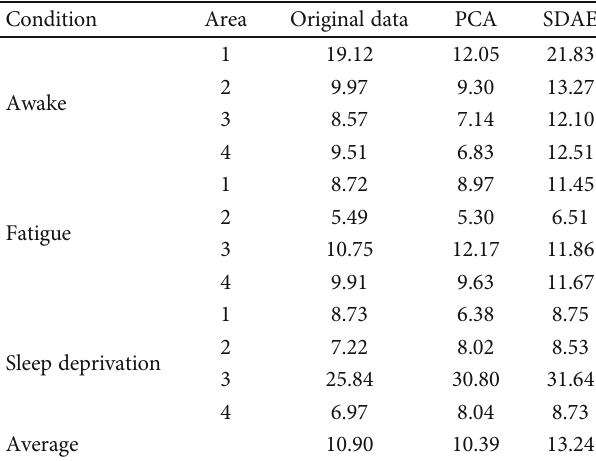
Table 2: RPFA on the three